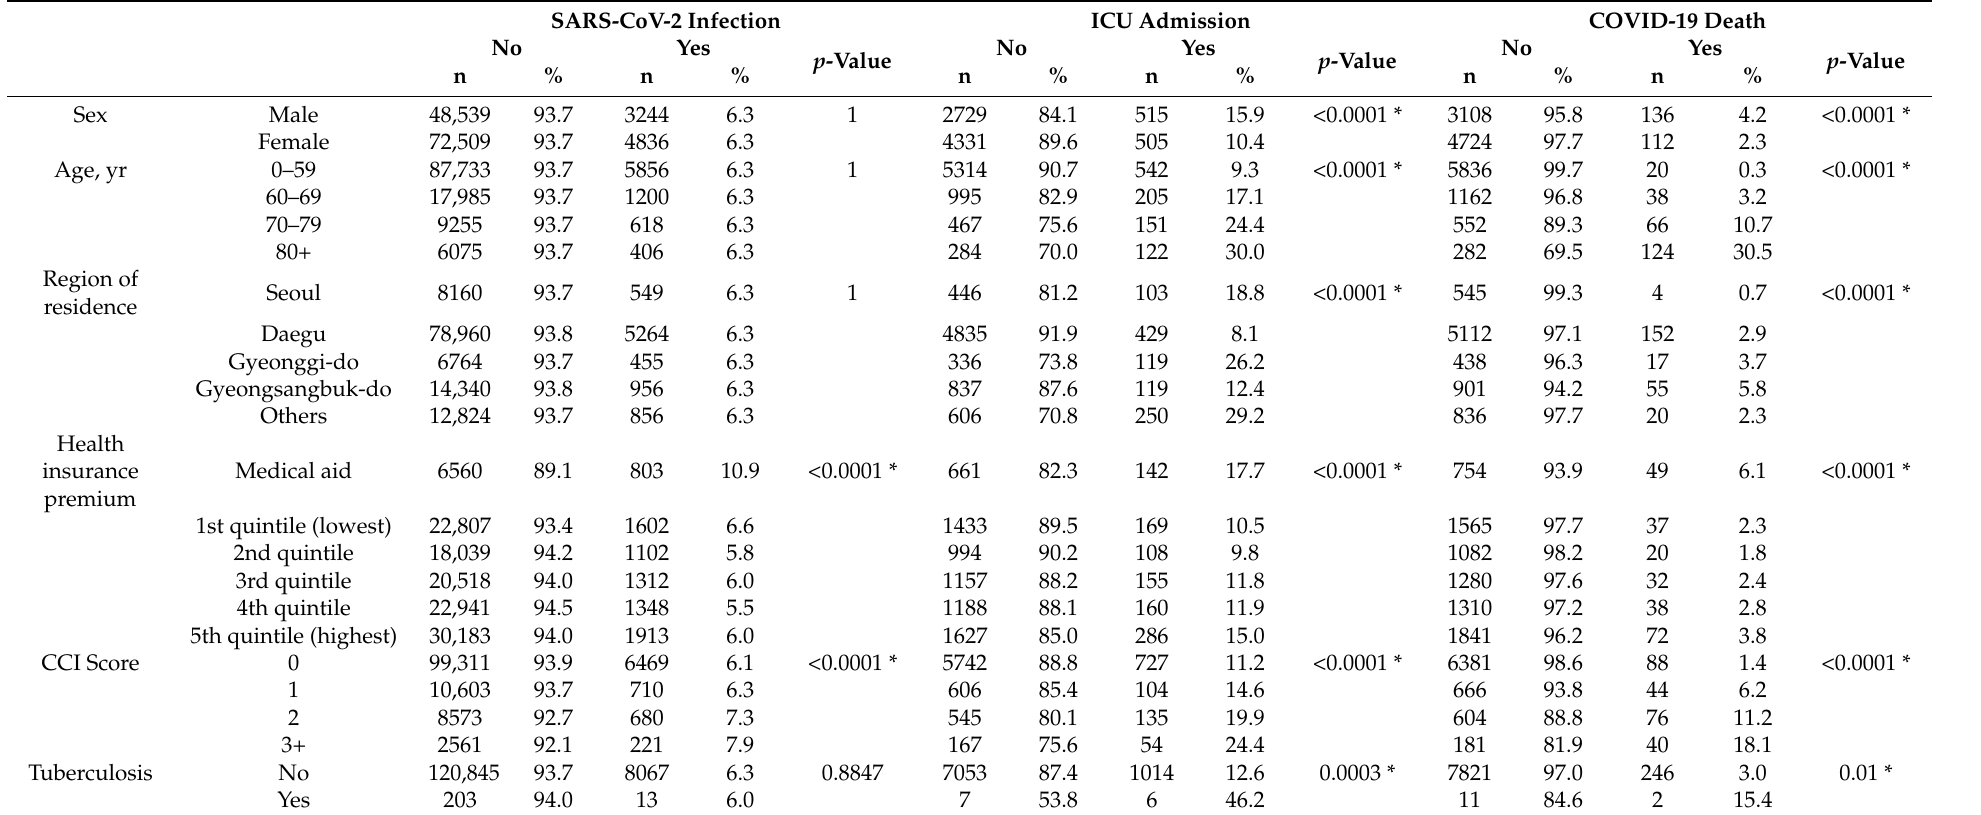
Table 1. Baseline